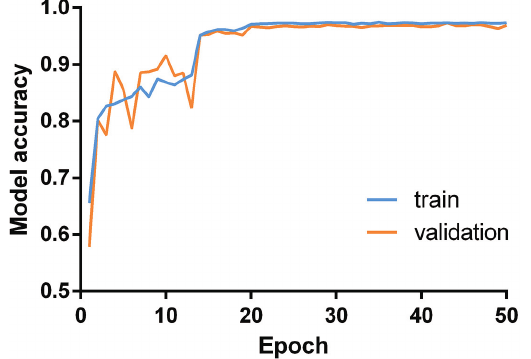
Fig. 3. The trend of model accuracy with the increase of epochs during the training. The accuracy of train datasets and validation datasets are indicated in blue and orange,